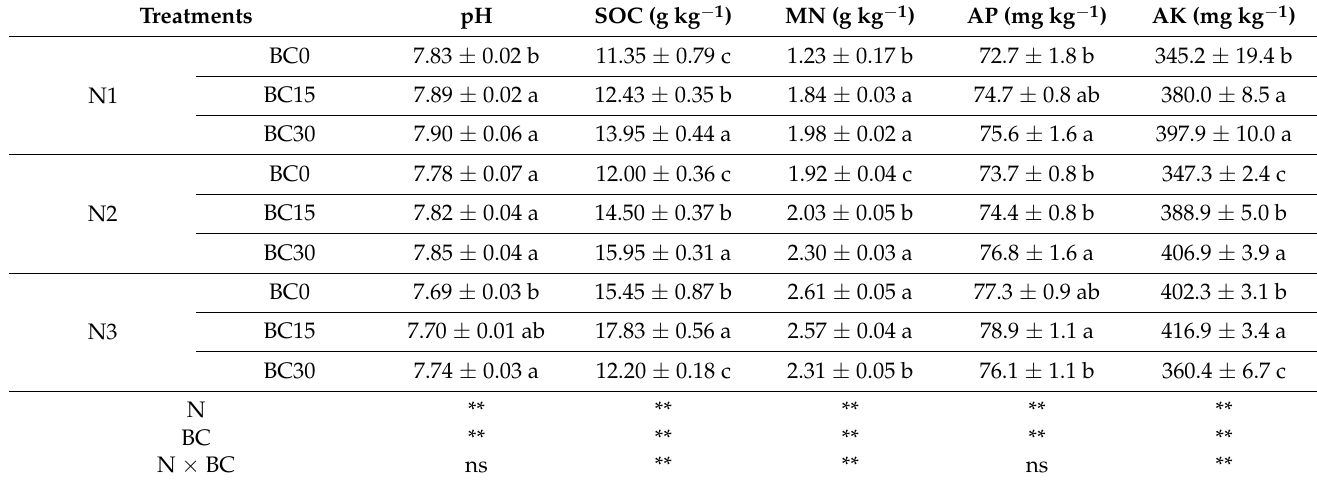
Table 2. Effects of nitrogen fertilizer and biochar on soil pH and nutrient contents.